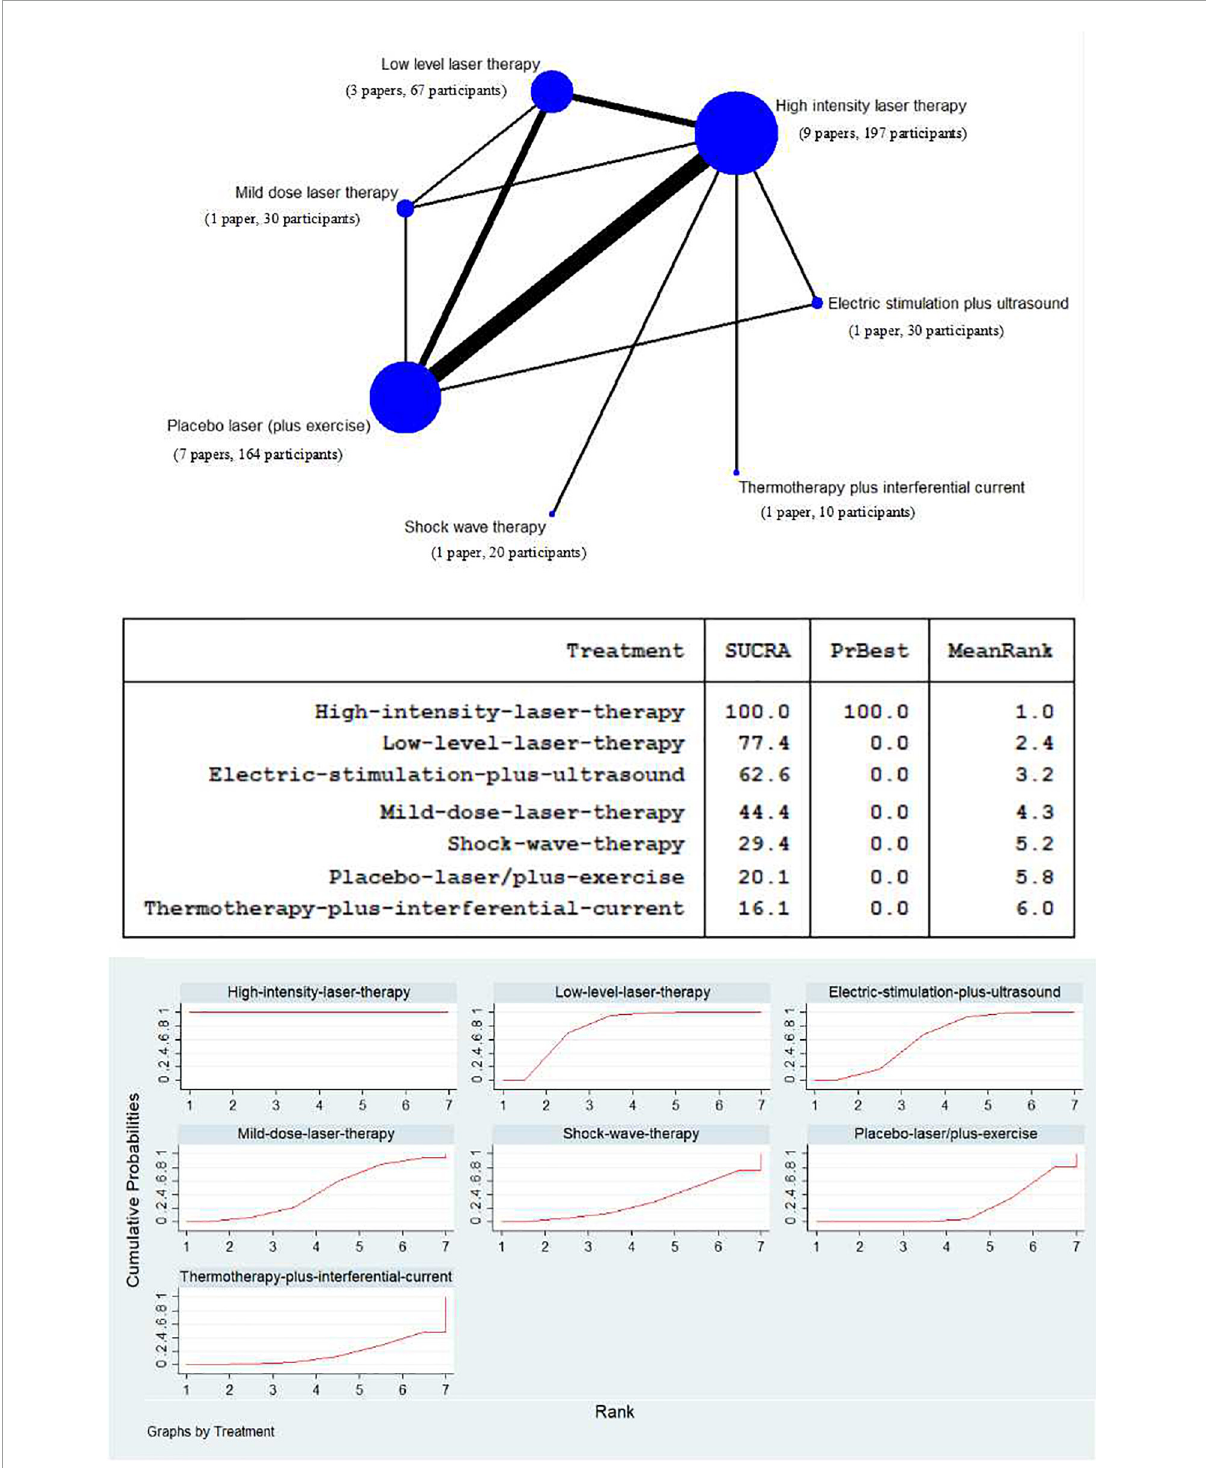
FIGURE3 Network meta-analysis plot for the assessment of high intensity laser therapy (HILT) and other physical therapy modalities (nodes are weighted in accordance with the number of trials including the respective treatments. The larger the size of node and the thicker the lines are, the more studies are involved). Treatment relative ranking [the PrBest means the estimated probability that the treatment is the best one. The lower the value of Mean Rank is, the higher the efficacy of the treatment may be. The ranking probability plot for the assessment of improved visual analog scale (VAS) pain at the end of the physical therapy modalities is